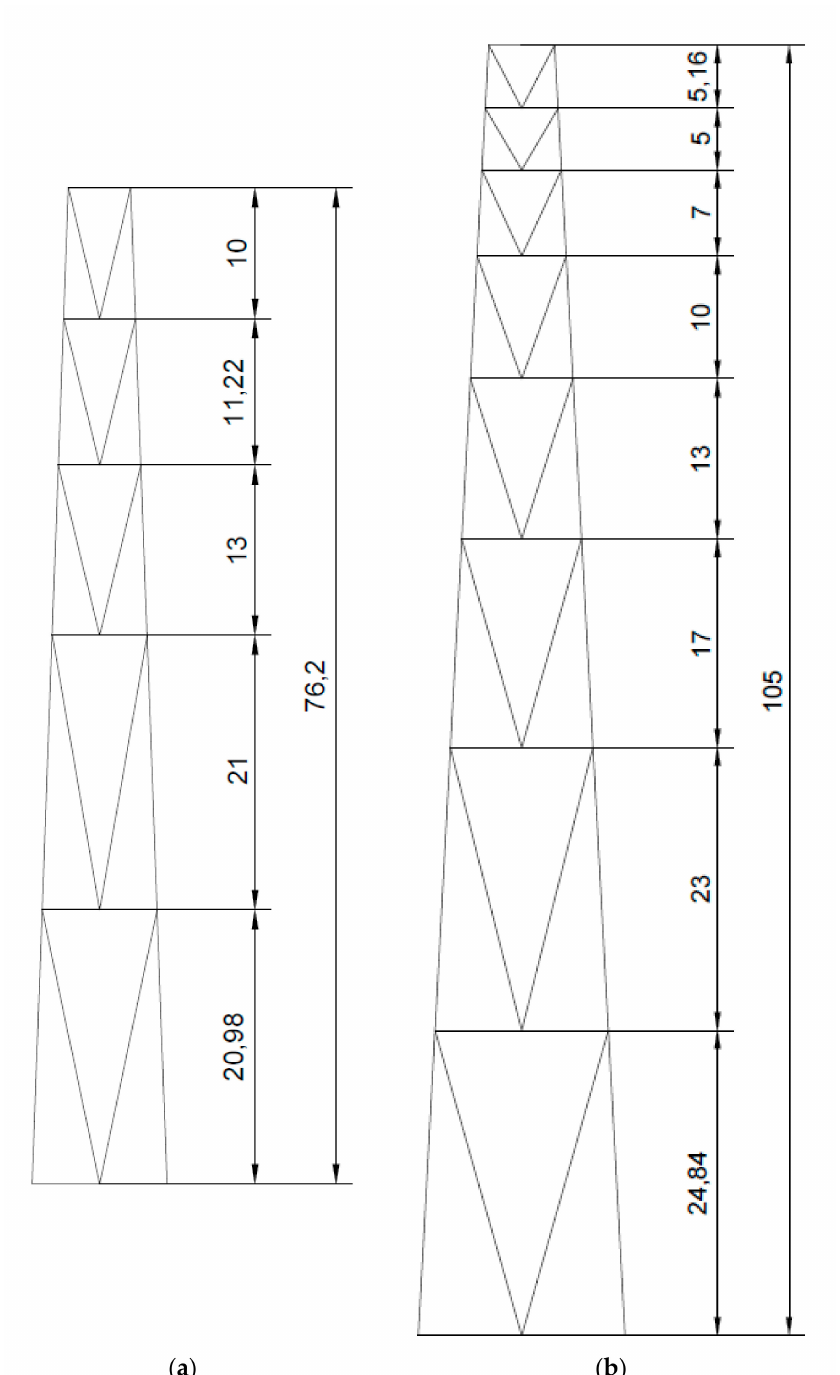
Figure 2. Lattice towers configuration: ( a ) Tower_L_A configuration of 76.2 m; ( b ) Tower_L_B configuration of 105.0